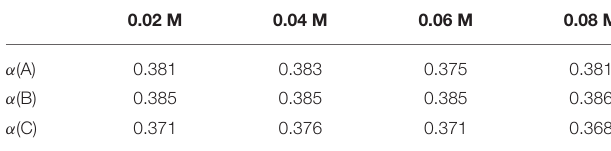
TABLE 2 | Values of the electron transfer coefficient α , estimated from Tafel-, Randles-Šev ˇ cík-, and Matsuda-Ayabe analysis.